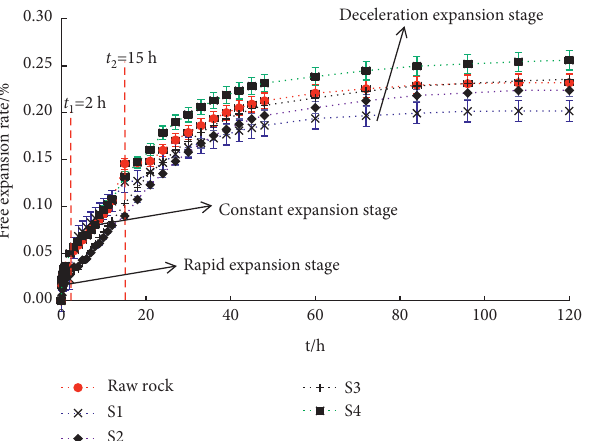
Figure 12: Axial expansion rate curve of silty mudstone and similar materials.